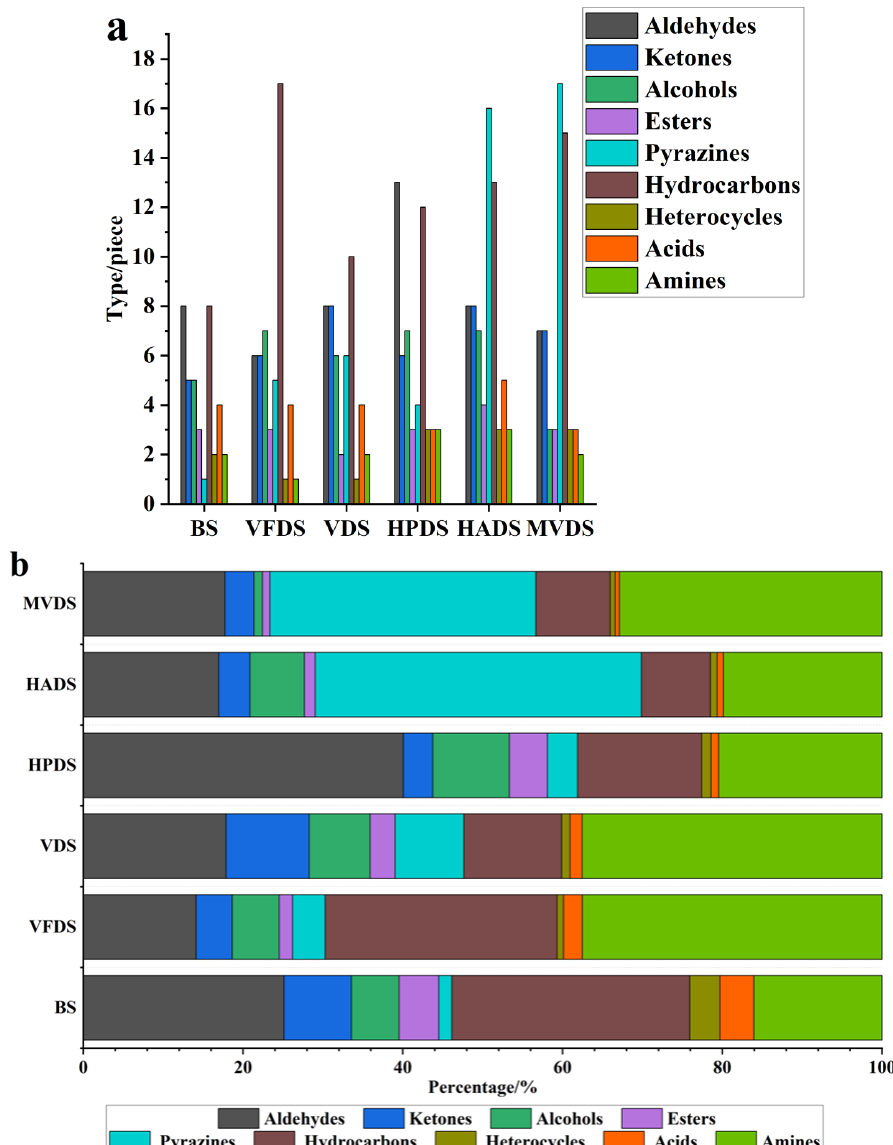
Figure 2. Comparison of volatile compounds in dried shrimps’ samples with different drying methods ( a ), Comparison of relative contents of volatile components in dried shrimp samples with different drying methods ( b ). BS: blanching shrimp; VFDS: freeze-dried vacuum shrimp; VDS: vacuum-dried shrimp; HPDS: heat pump-dried shrimp; HADS: hot air-dried shrimp; MVDS: microwave vacuum-dried